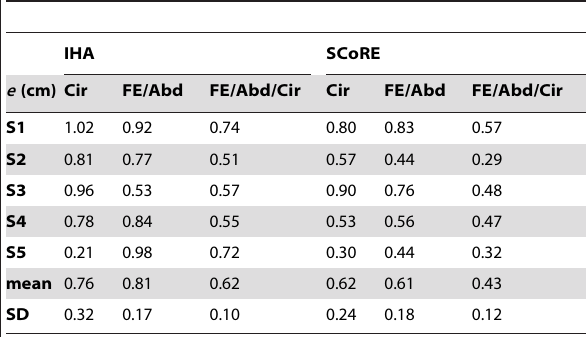
Table 2. The repeatability error ( e ) for the IHA and SCoRE